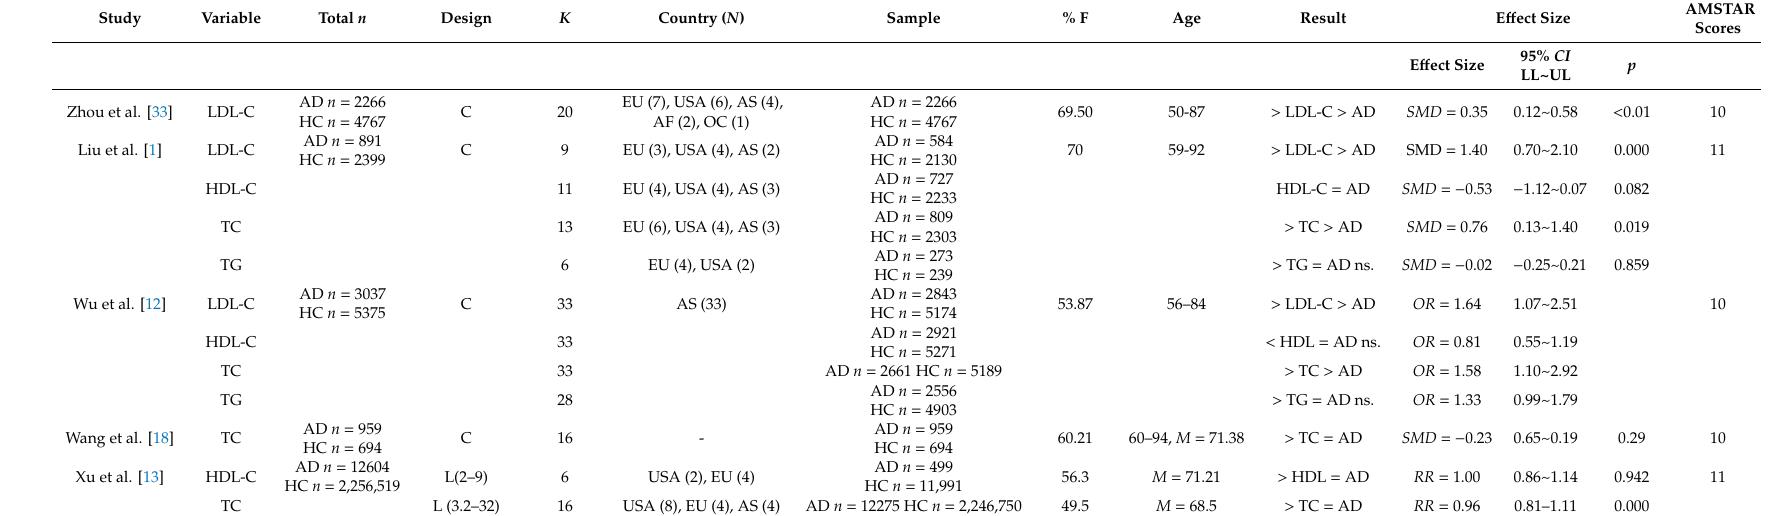
Table 1. Population characteristics in studies of Alzheimer’s disease (AD)and